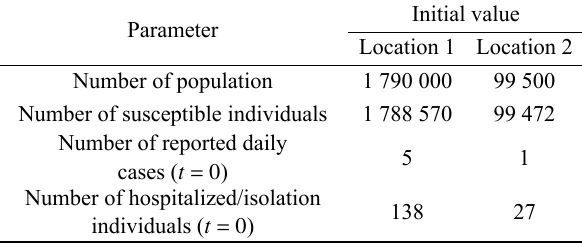
Table 1 Initial parameter values for